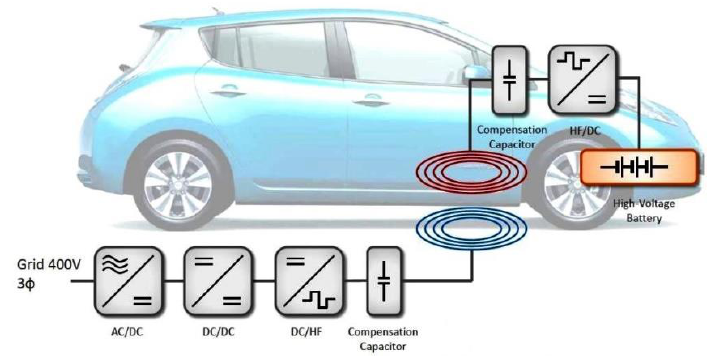
Figure 5. The S-WEVC system.